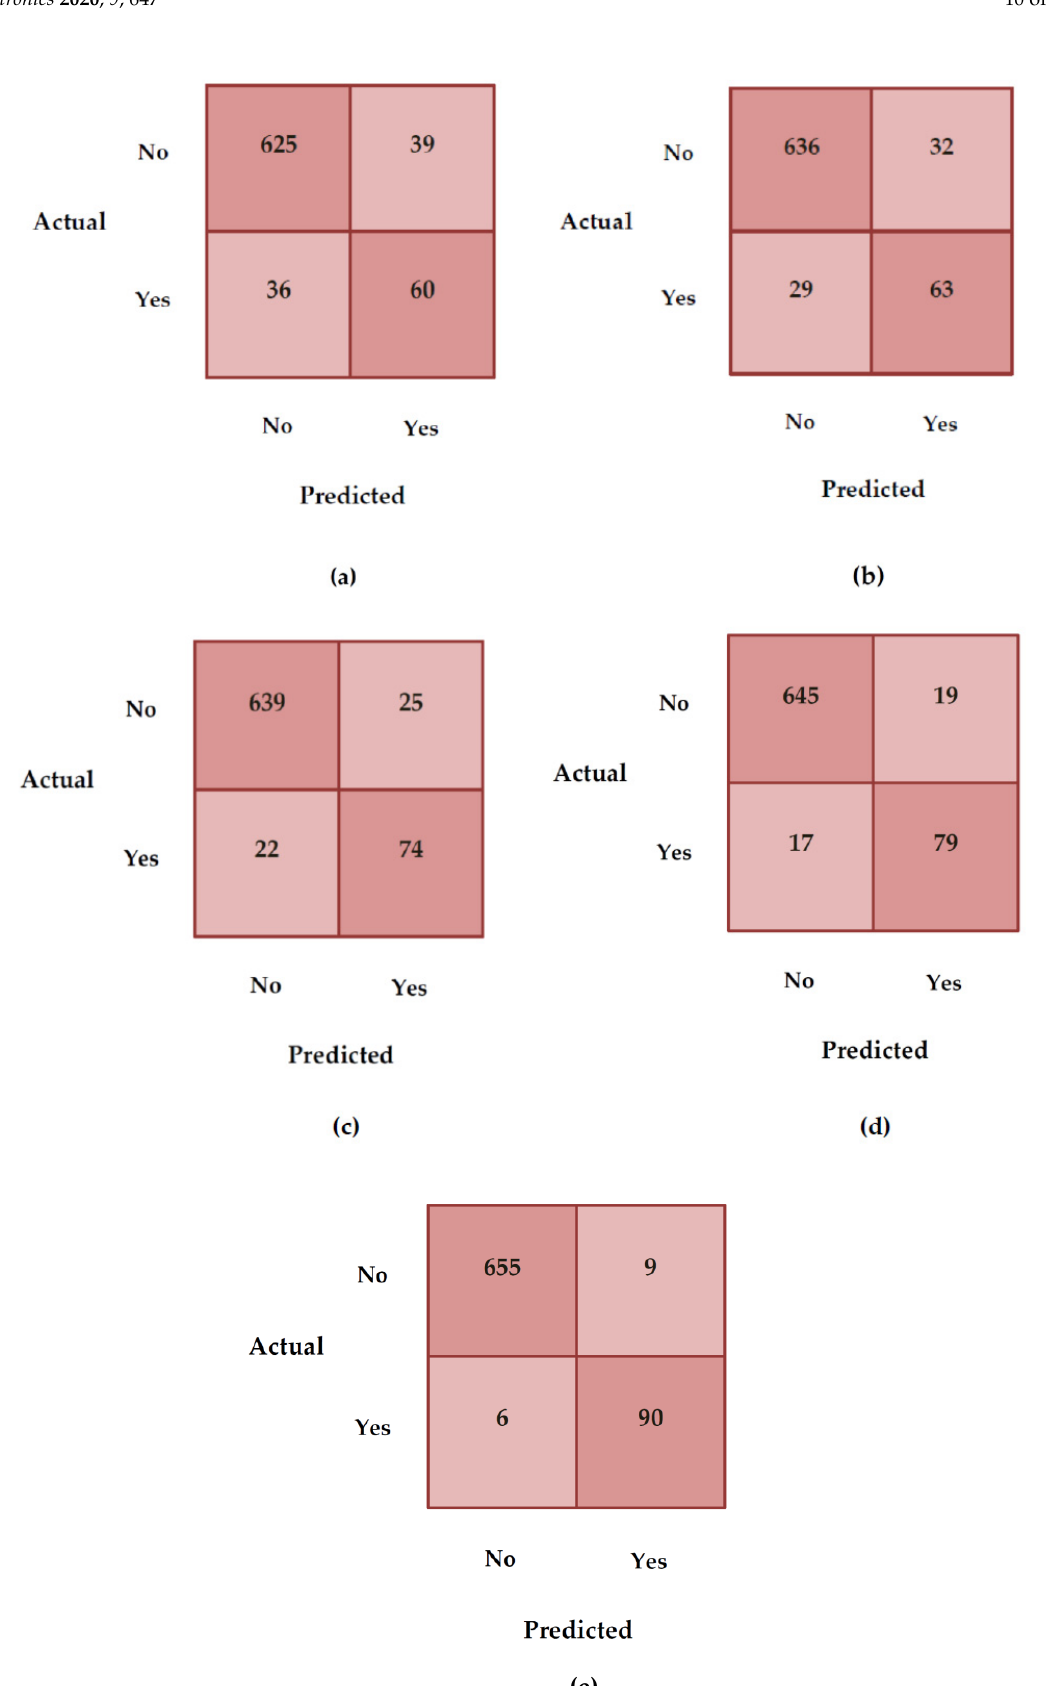
Figure 3. Confusion matrix: ( a ) Logistic regression (LR), ( b ) multilayer perceptron (MLP), ( c ) Random Forest (RF), ( d ) bagging SVM (majority voting), and the ( e ) proposed model.